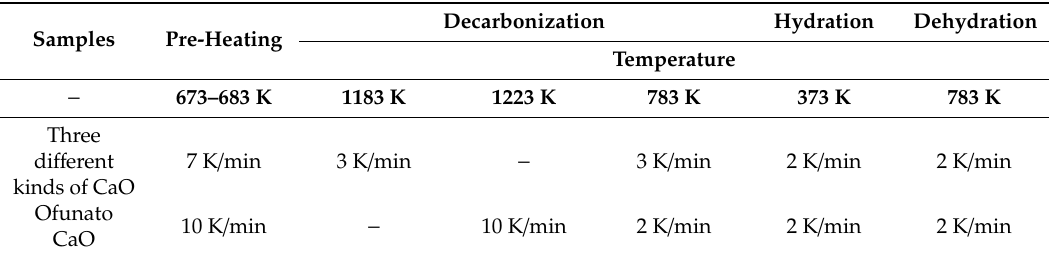
Table 2. Di ff erent decarbonization, hydration and dehydration temperature conditions in TGA-51.